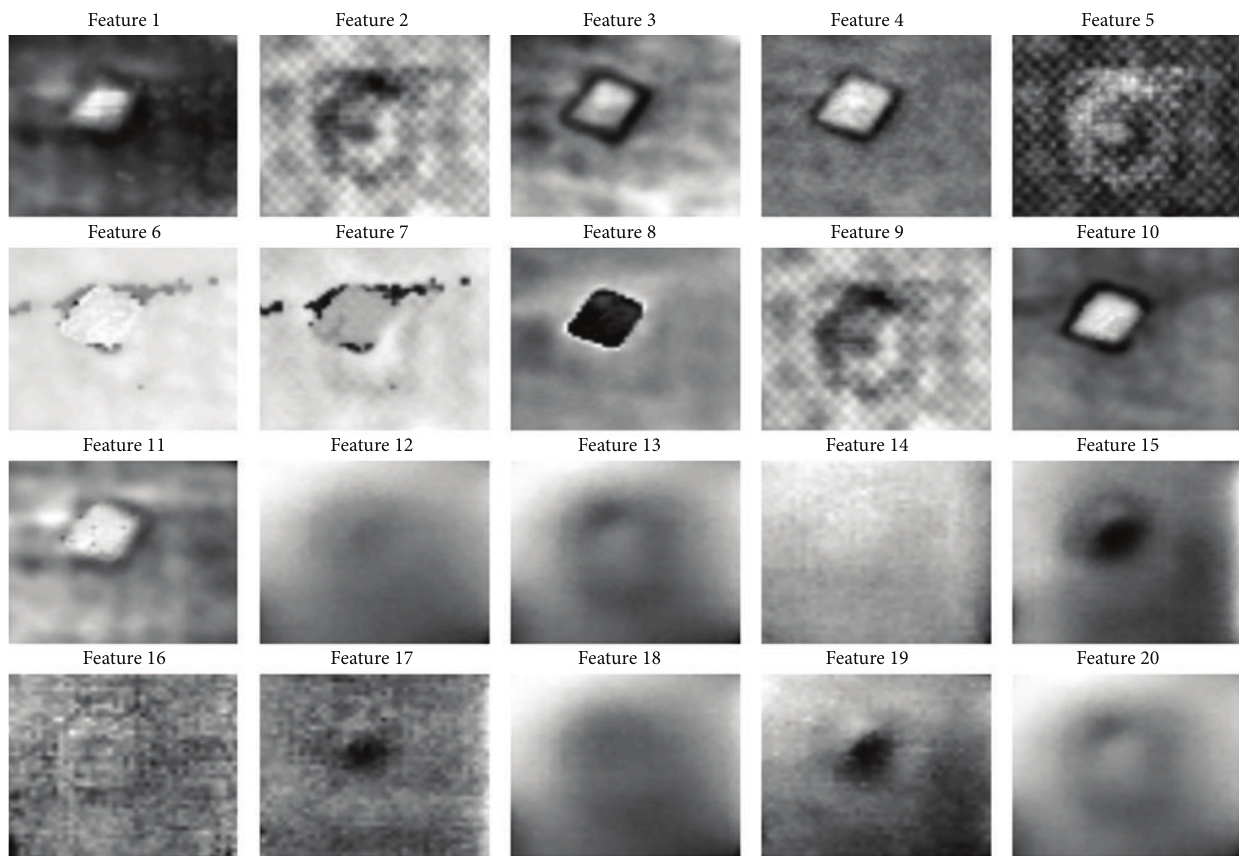
Figure 15: Results of the data registration process carried out for features vector obtained for sample with inclusion B.